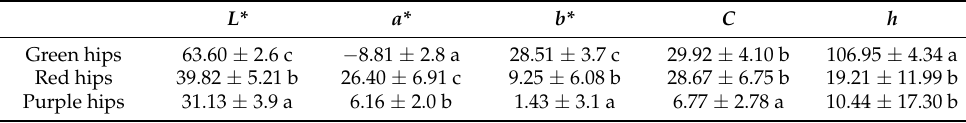
Table 1. Fruit color parameters of Rosa xanthina f. spontanea hips during ripening.